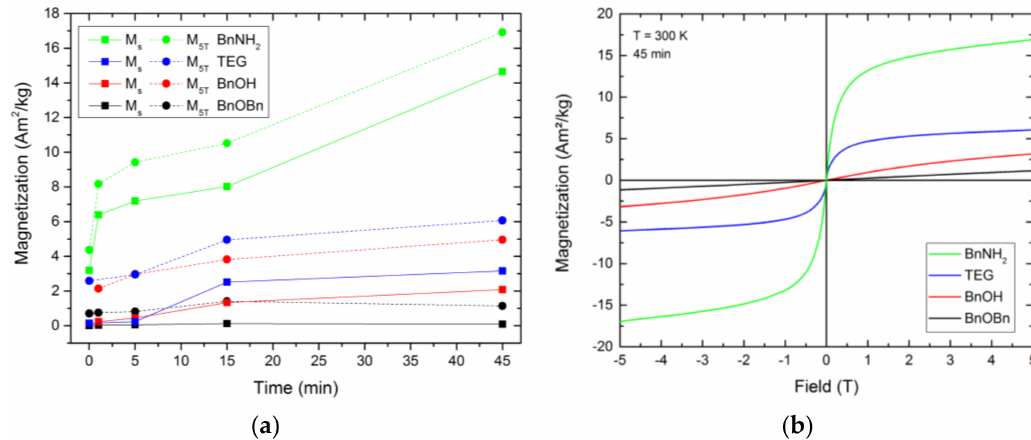
Figure 6. Saturation magnetization and magnetization at 5 T ( a ) as well as the superparamagnetic curves after 45 min reaction time ( b ) of the fcc-FePt nanoparticles derived from the reference synthesis (black) as well as alternative synthetic routes (red, blue,